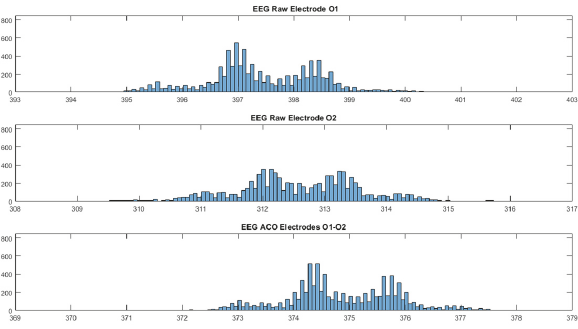
Figure 23: The probability density function of the original signals and the optimized signal.